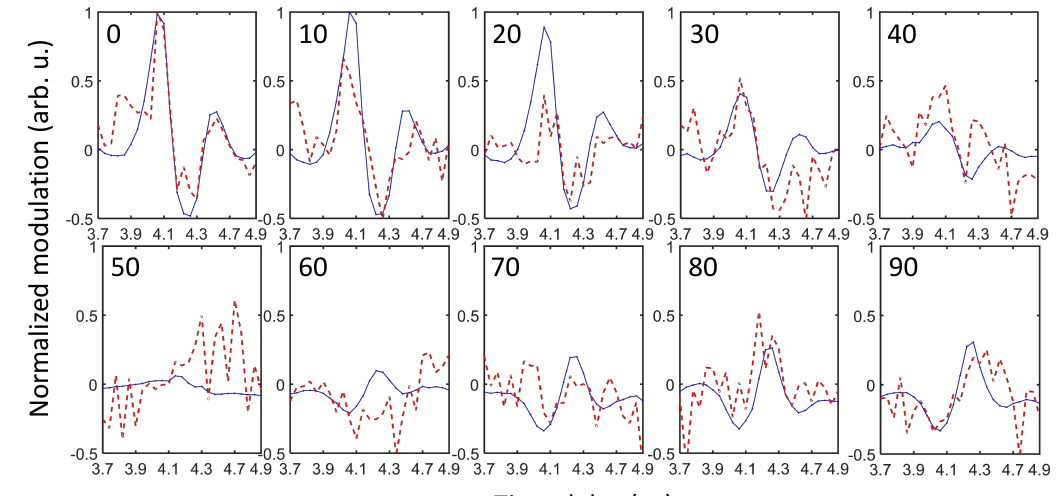
Figure 6. The modulations of the relative yields of the 21st harmonic (the blue solid lines) and the THz (the red dashed lines) as functions of the time delay between aligning and generation pulses with different aligned angles. The alignment angle is indicated in degrees at the top left corner of each